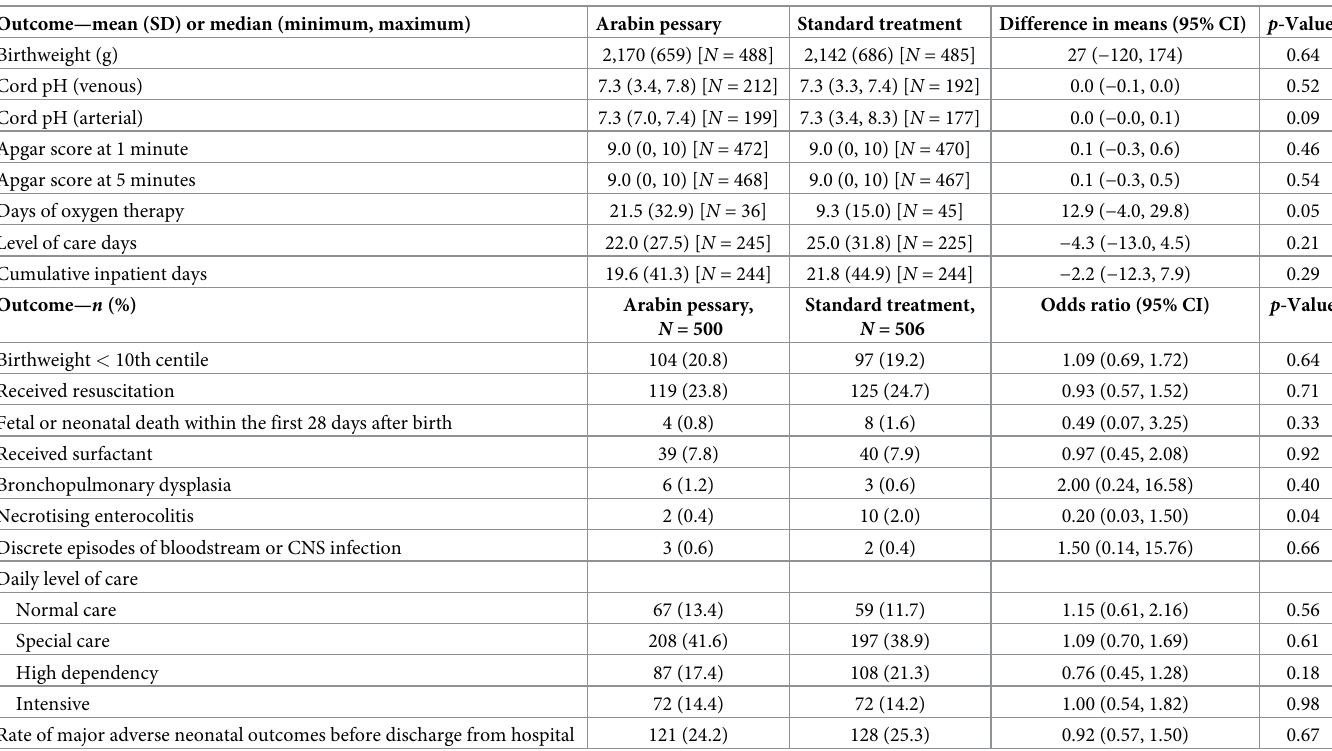
Data refer to all twins, with the 95% CIs and p -values adjusted for clustering within twins. CNS, central nervous system.